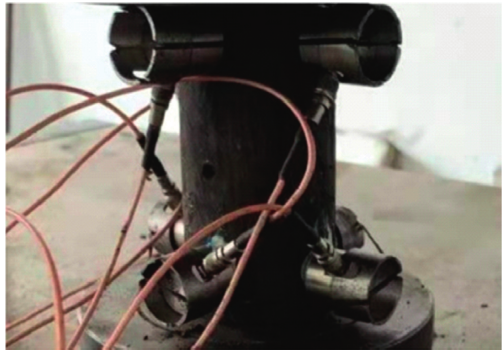
Figure 2: Sensor placement. Table 1: Test scheme.